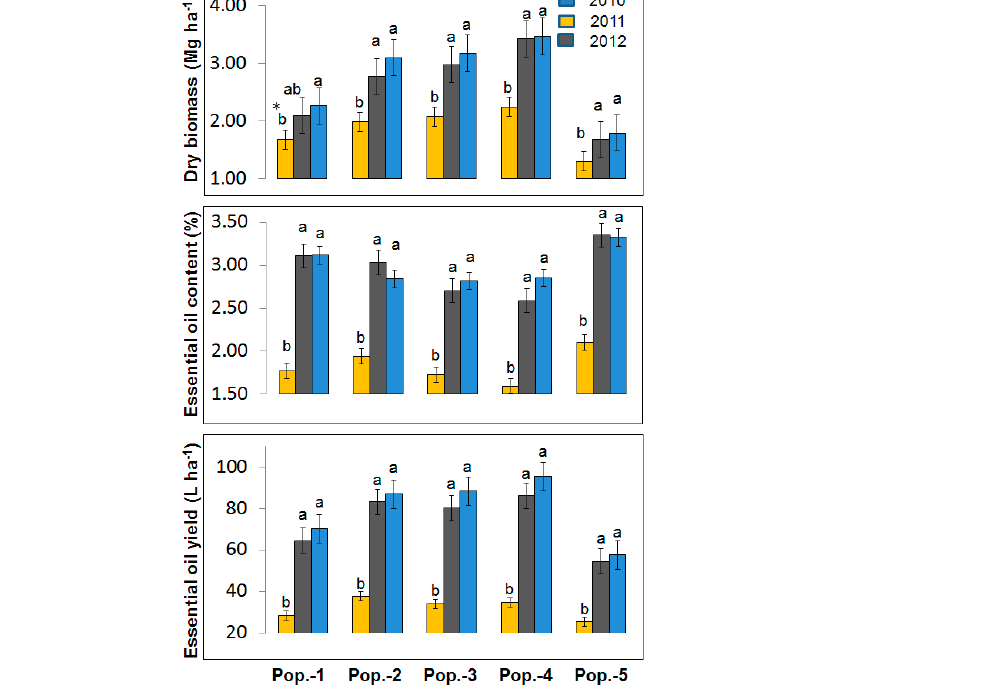
Figure 2. Mean values for (a) dry biomass production (Mg ha − 1 ), (b) essential oil content (mL 100 g − 1 DW) and (c) essential oil yield (L ha − 1 ) for each of the oregano populations (1-Panagia, 2-Litochoro, 3-Omolio, 4-Papadates, 5-Vytina), averaged for the four nitrogen fertilization levels (control, N1, N2, N3, that correspond to 0, 40, 80 and 120 kg N ha − 1 , respectively), with respect to each cultivation year. * For each population mean values ( ± S.E.) followed by different letters are significantly different at p < 0.05 .